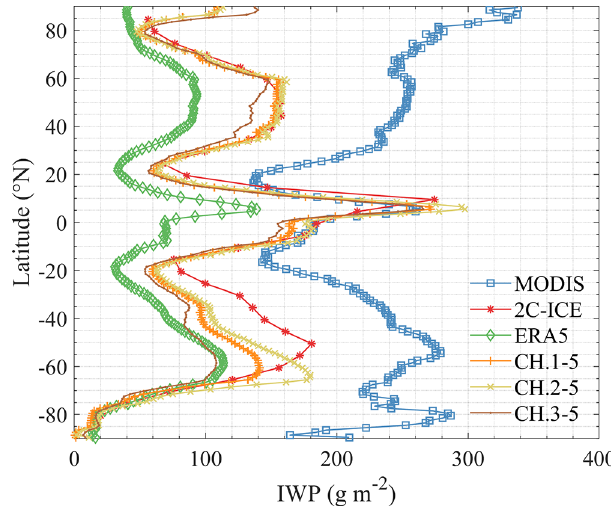
Figure 15. Zonal means of IWP for 2015 from MODIS, 2C-ICE, ERA5, and different channel combinations from MWHS. The 2C- ICE is gridded on a 5 ◦ grid, while the other products are gridded on a 1 ◦